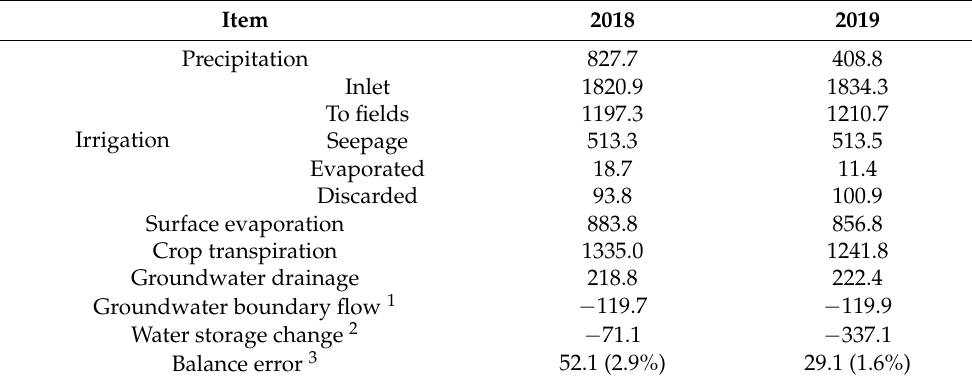
Table 3. The overall water balance (unit: 10 4 m 3 ).